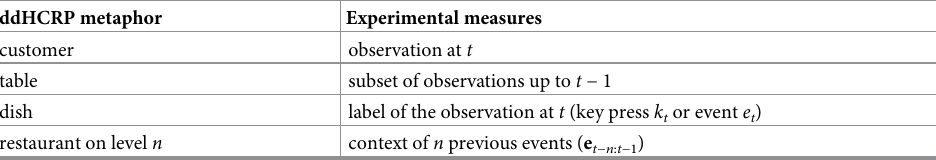
Table 1. Terminology of the hierarchical Chinese restaurant process mapped onto the experimental measures of the current study.